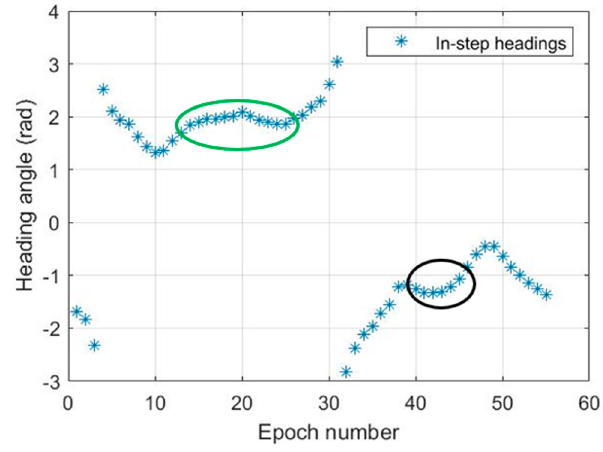
Figure 11. In − step headings of interest.